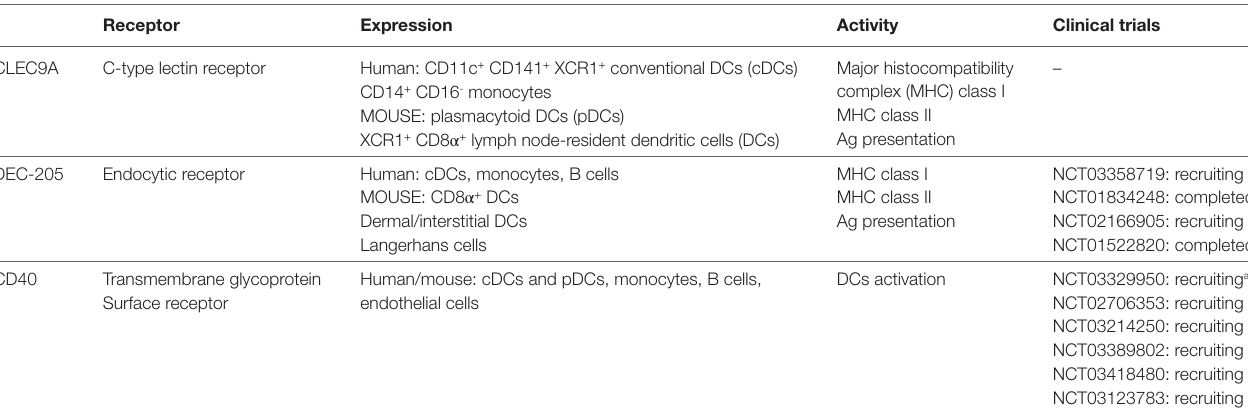
TABLe 1 | Targeted receptors for tailored ags